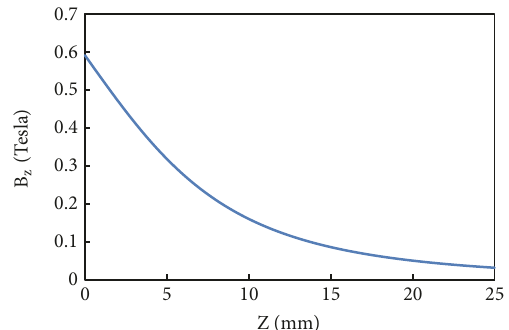
Figure 6: Magnetic flux density vs. distance from the surface of the magnet to the